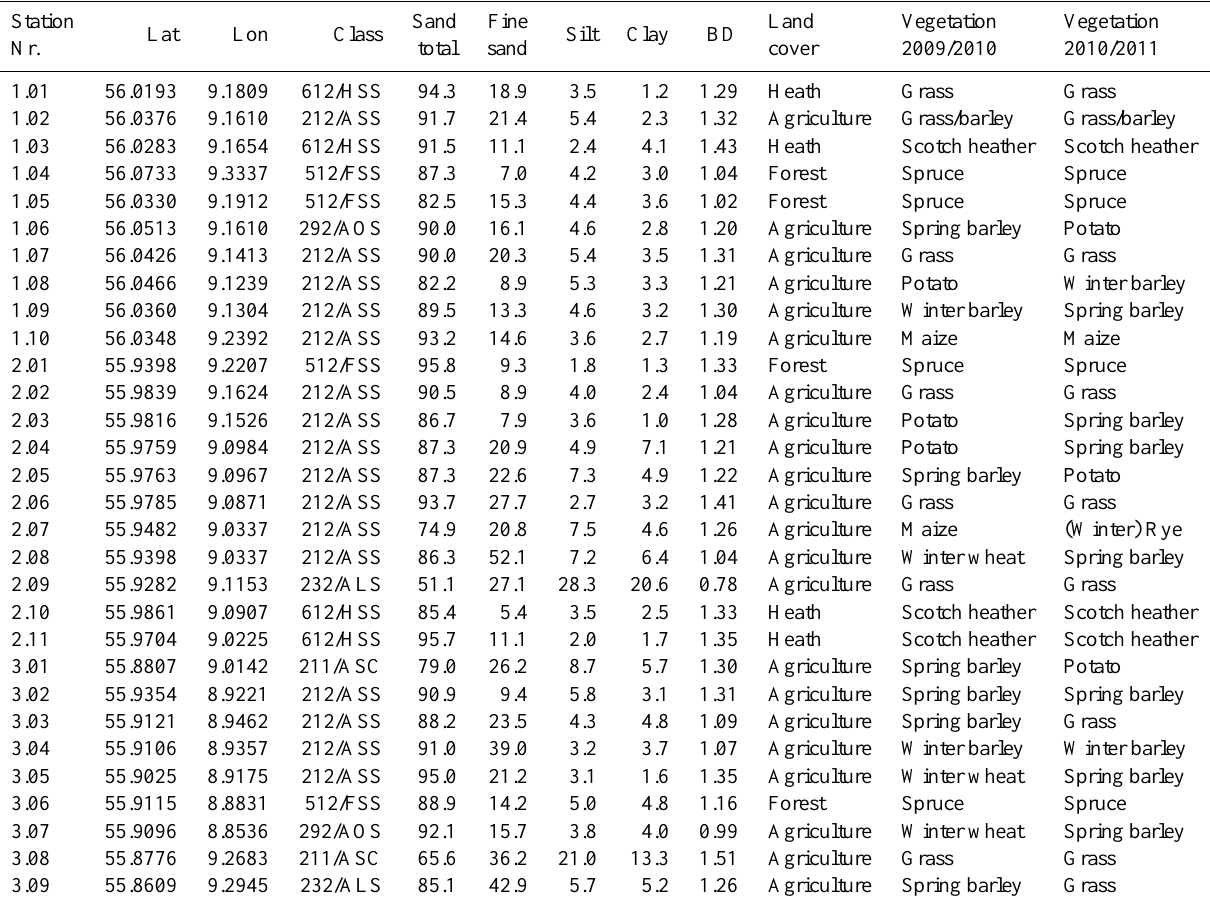
Table 6. Overview of the 30 network stations: station number, latitude, longitude, composite class number/description, total sand, fine sand, silt, and clay fractions at 0–5cm depth [%], bulk density (BD) at 0–5cm depth [gm − 3 ], land cover, and vegetation 2009/2010 and 2010/2011,